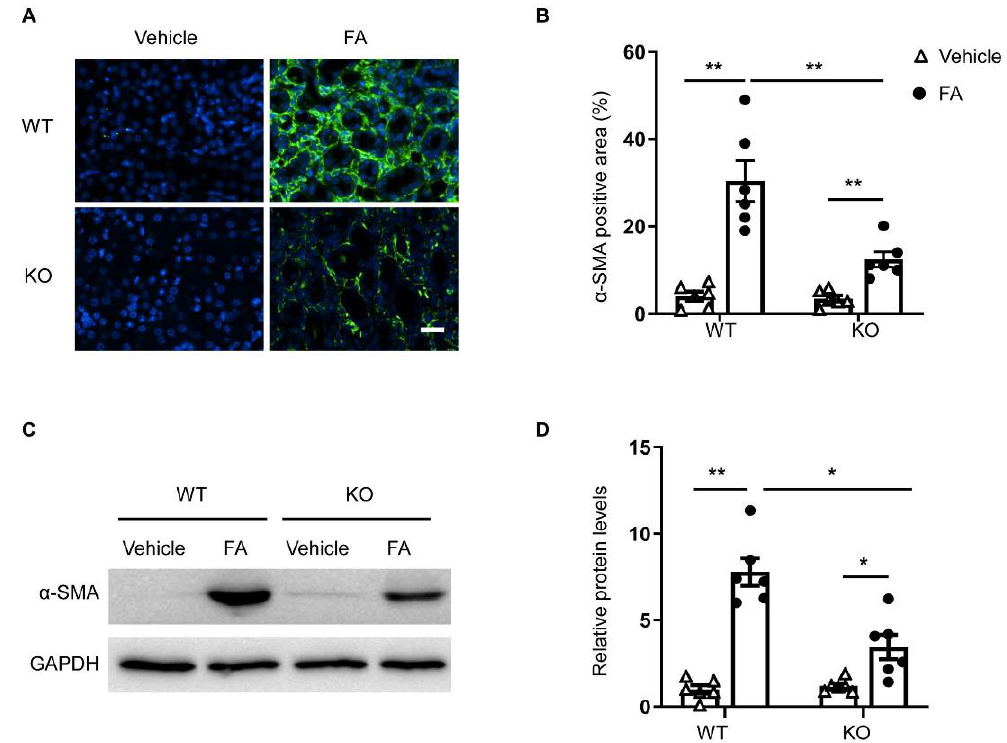
Figure 4. STAT6 deficiency reduces myofibroblast formation in folic acid nephropathy. ( A ) Representative photomicrographs of kidney sections immunostained for α -SMA (green) and counterstained with DAPI (blue). Scale bar, 50 µ m. ( B ) Quantitative analysis of the α -SMA-positive area in the kidneys. ** p < 0.01. n = 6 per group. ( C ) Representative Western blots show α -SMA protein levels in the kidneys. ( D ) Quantitative analysis of α -SMA protein expression in the kidneys. ** p < 0.01, * p < 0.05. n = 6 per